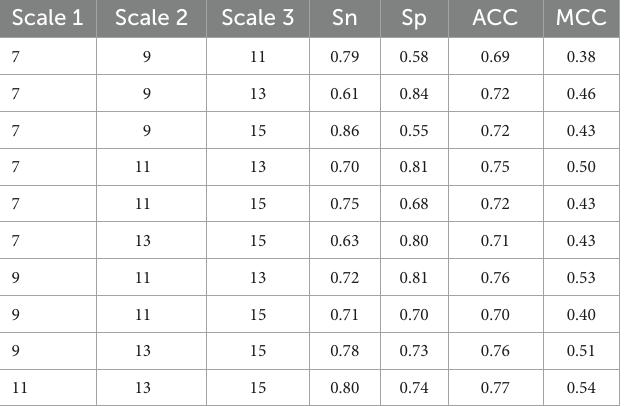
TABLE 5 Comparison with existing models on the ILED 2195 independent dataset.